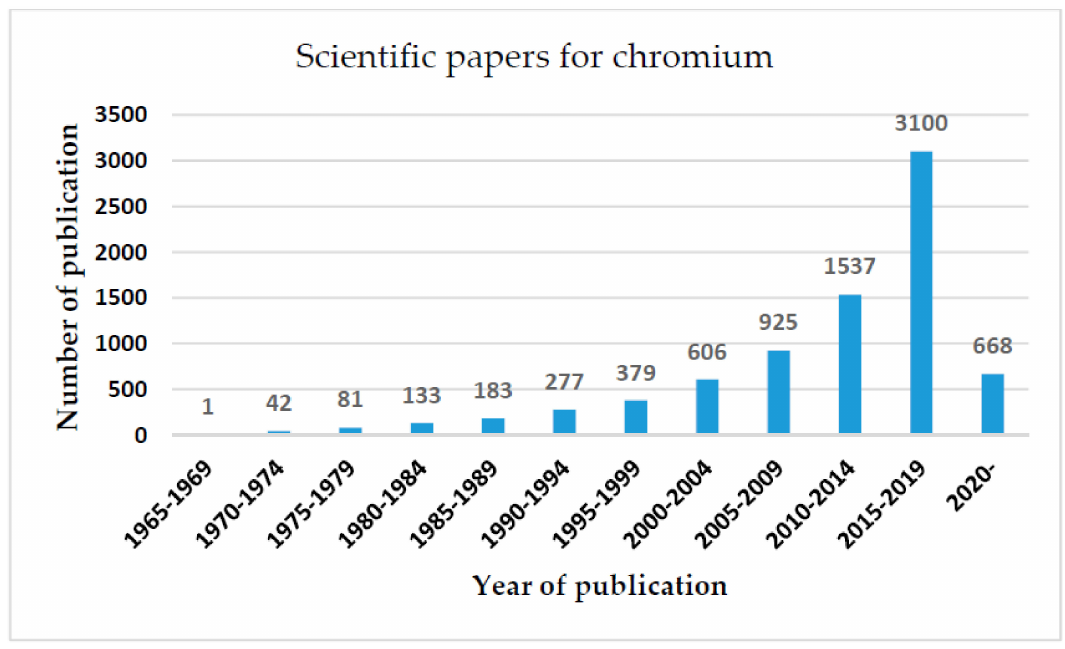
Figure 1. Number of publications in the field of electrochemical detection of chromium in the period between 1965 and 2020 (www.scopus.com, analyzed by 5 years) (Consulted 20-07-2020) (Keywords: (Chromium) and (electrochemical) and (detection or determination or